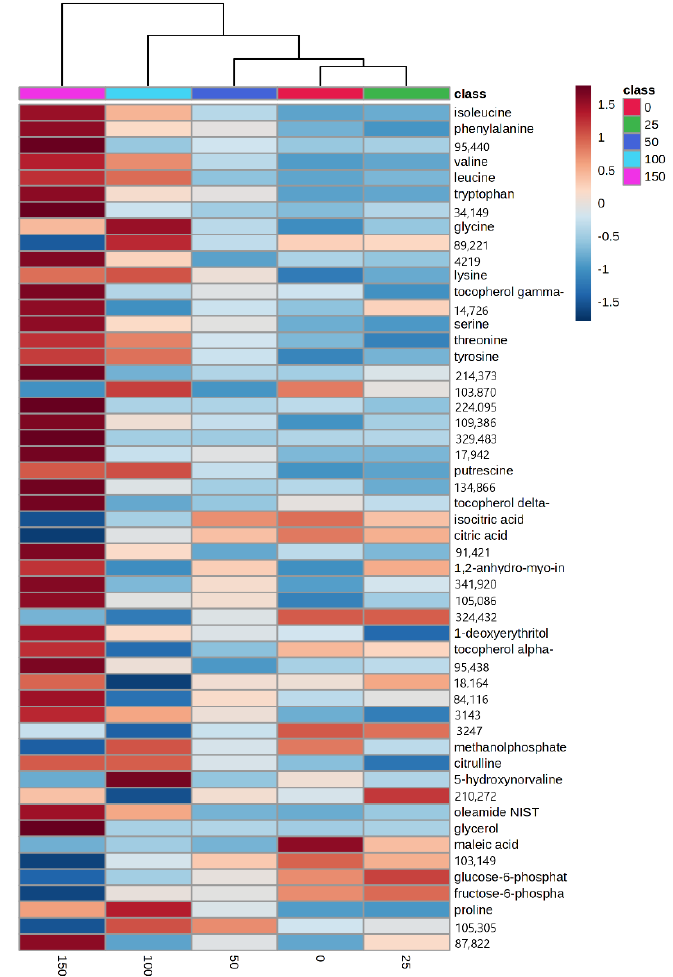
Figure 5. A heat map provides an intuitive visualization of metabolites found in this study. Each colored cell on the map corresponds to a concentration value in the data table, with samples in rows and metabolites in columns. Displayed are the top 52 metabolites ranked by t − tests with p − values by ANOVA of < 0.05 and FDR < 0.05.